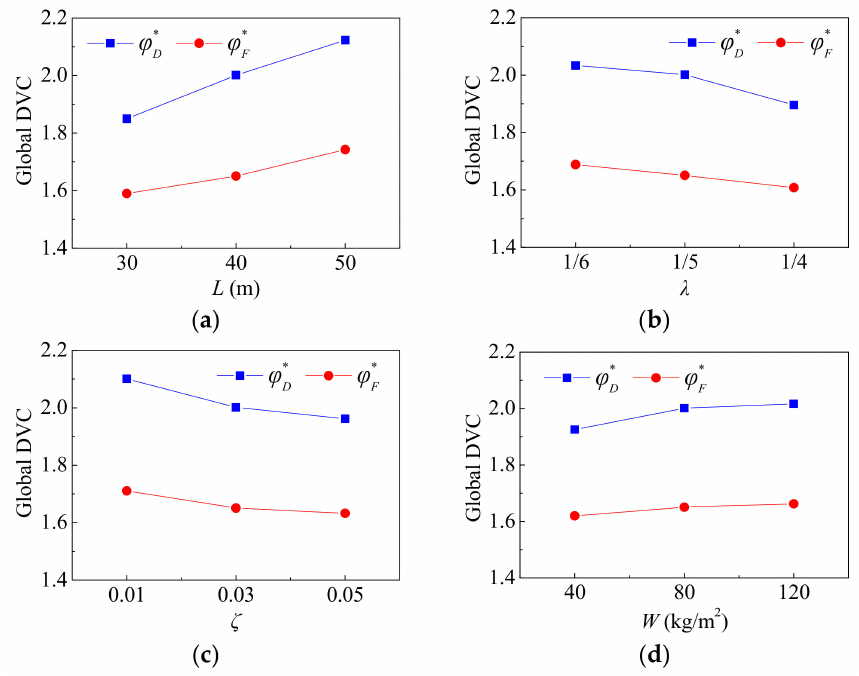
Figure 11. Influences of structural parameters on the global DVCs: ( a ) span; ( b ) rise–span ratio; ( c ) damping ratio; ( d ) roof